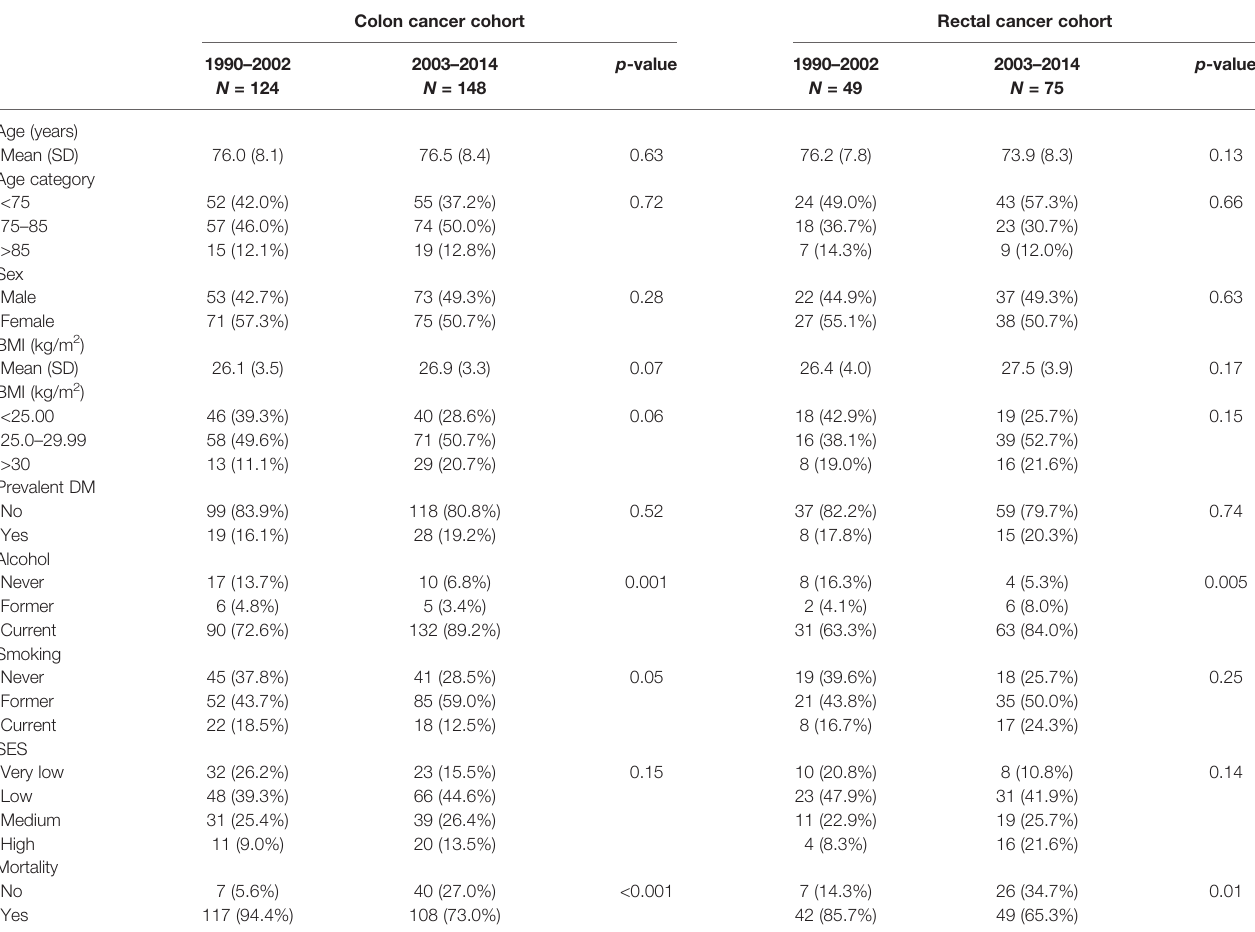
TABLE 1 | Patient